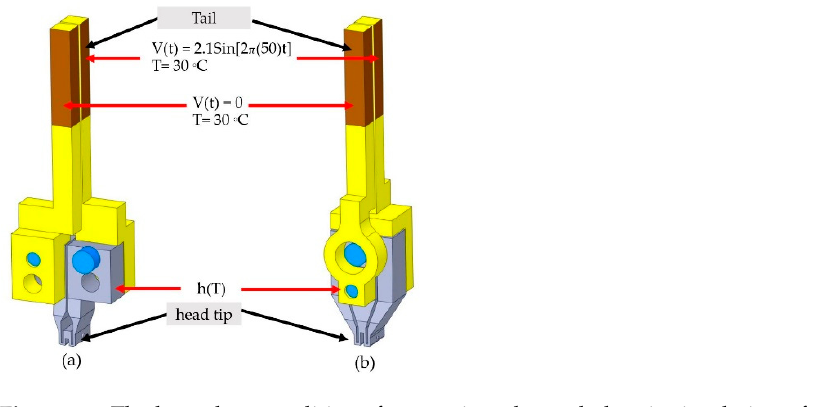
Figure 10. The boundary conditions for transient thermal-electric simulation of ( a ) series and ( b ) parallel WTs. Table 1. Material properties for setting in simulations [3].